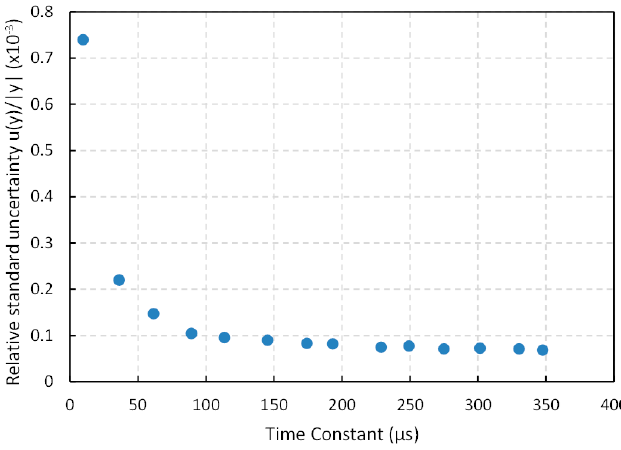
Figure 15. Relative standard uncertainty versus the time constant for the capture module in Section 3.6.